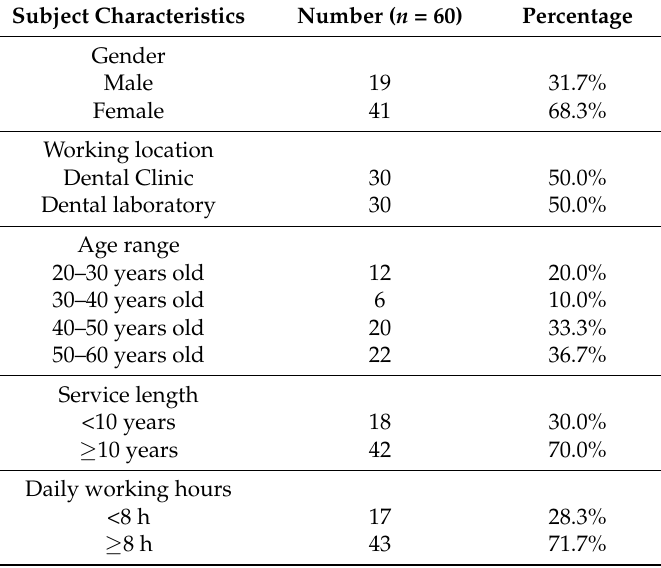
Table 2. Summary of the dental professionals’